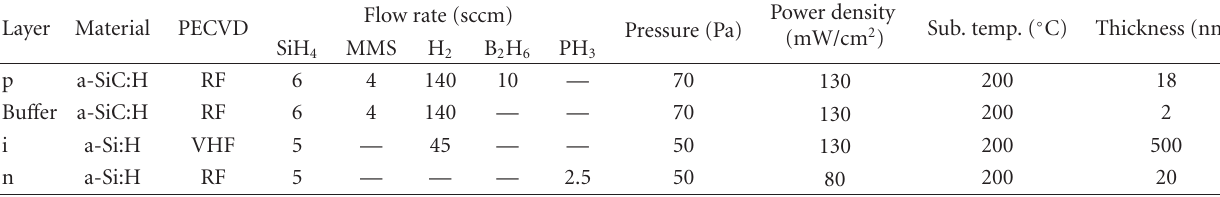
Table 3: a-Si:H films deposition parameters.